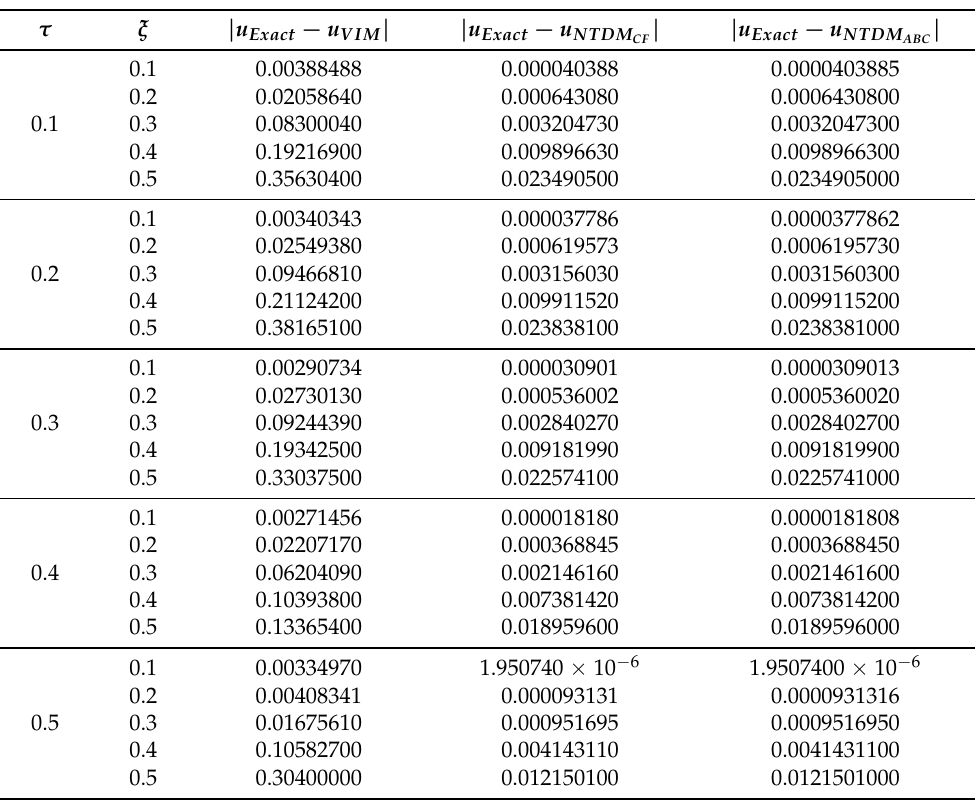
Table 6. Comparative study between VIM, NTDM CF and NTDM ABC for the approximate